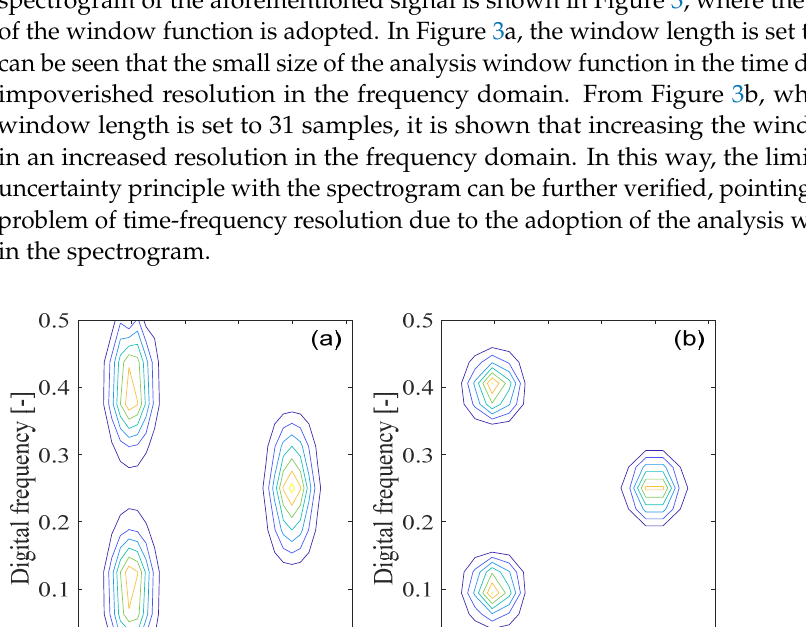
Figure 2. The spectrogram of nonstationary signal composed of three transient Gaussian components; ( a ) Chebyshev window; ( b ) Kaiser window.